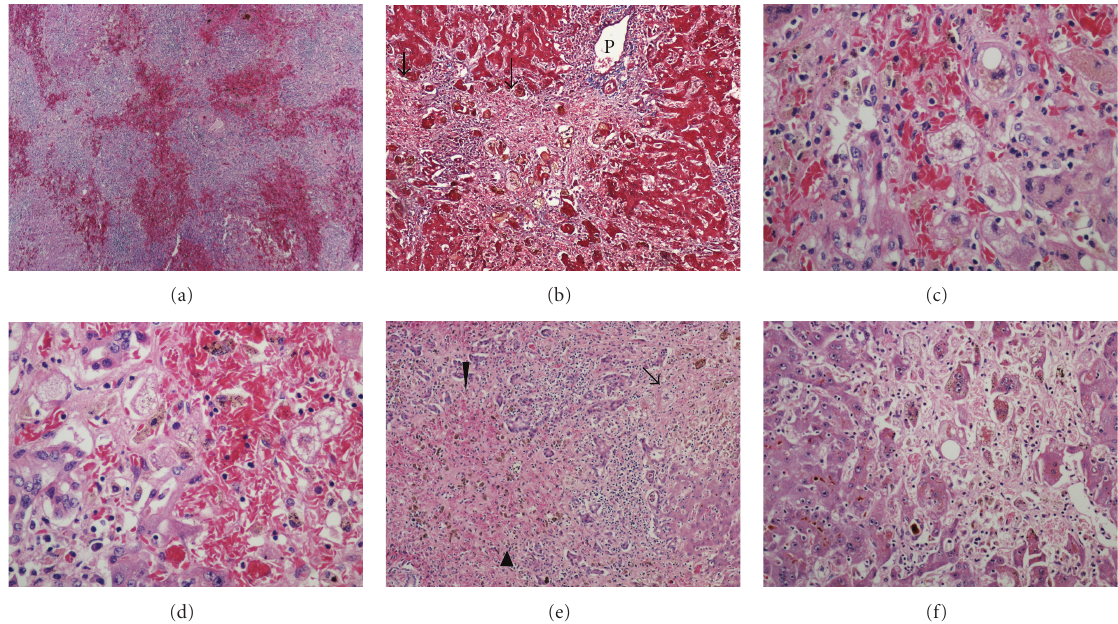
Figure 2: Histologic sections from the explanted liver. (a) The portal tracts are close together separated by hemorrhagic areas with hepatocyte loss (H&E, × 20). (b) Trichrome stain highlights a portal tract (P), but pale areas of parenchymal collapse (arrows) are unstained ( × 100). (c) Hepatocytes with microvesicular steatosis and sickled red blood cells (H&E, × 200). (d) Ductular hepatocytes and inflammatory cells adjacent to an area with hepatocyte loss and sickled cells (H&E, × 200). (e) Periportal ductular hepatocytes in an area of confluent necrosis. Microvesicular steatosis (arrow) and sickled cells of varying ages (arrow heads) are also highlighted in this section (H&E, × 40). (f). Regenerating hepatocytes adjacent to an older area of parenchymal loss. Note multinucleated giant hepatocytes with cholestasis in a largely hypocellular background with some macrophages (H&E, ×